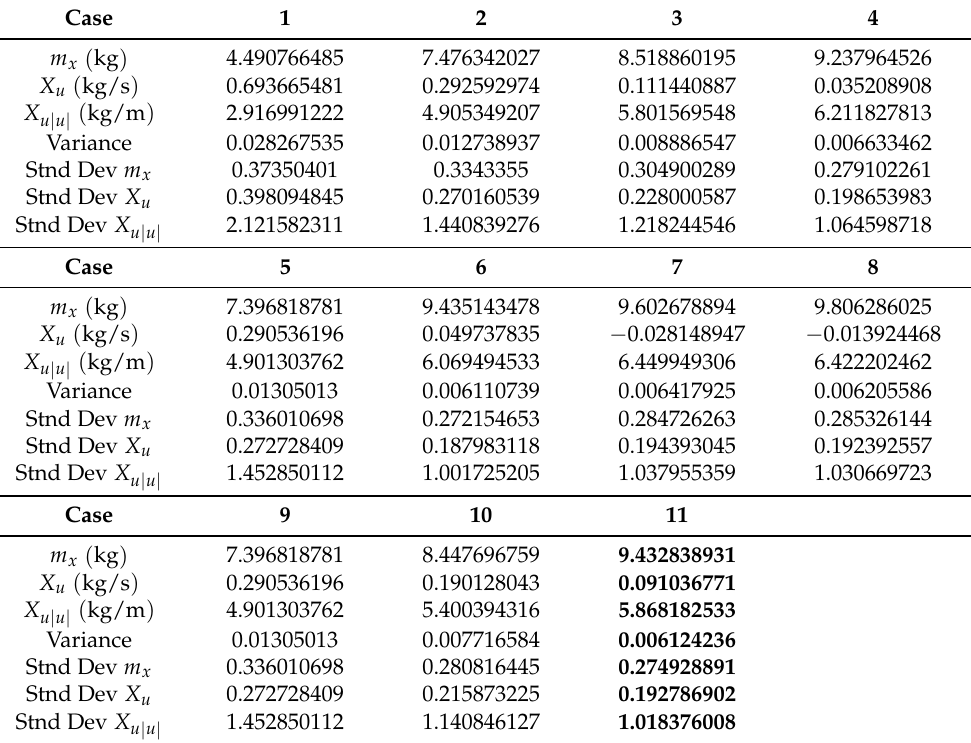
Table A3. Results of the estimation of hydrodynamic parameters for the negative motion in b x with 150 iterations.